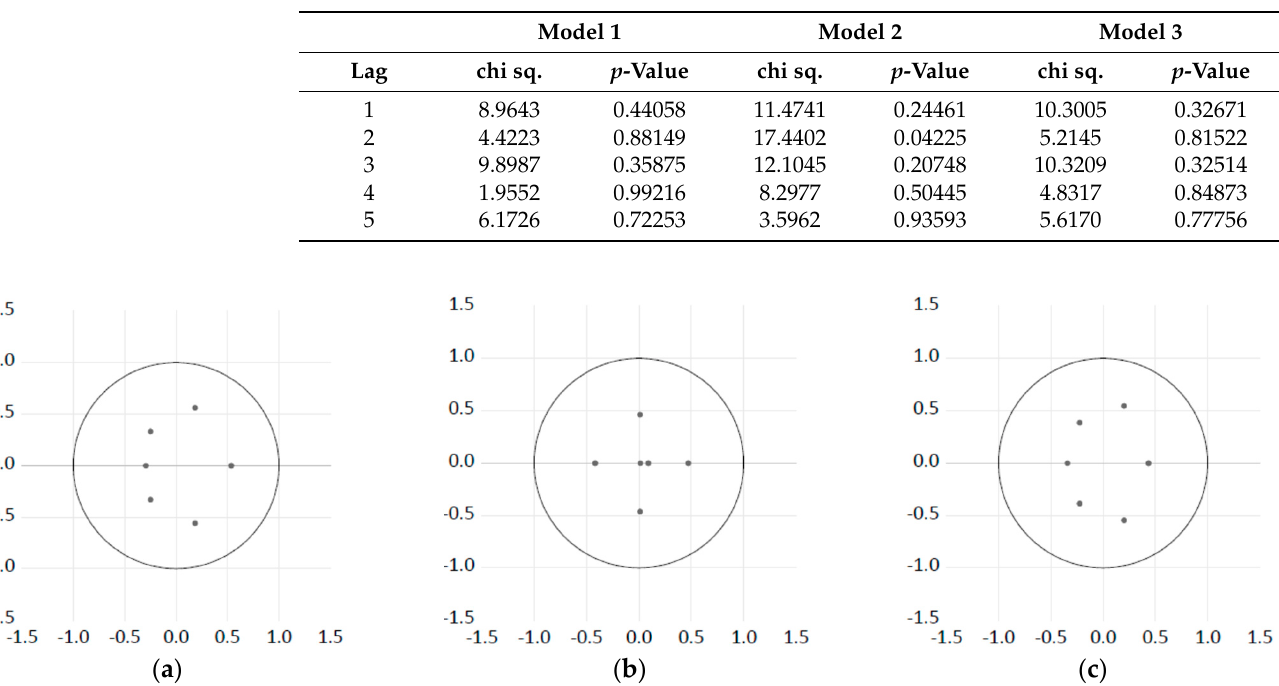
Figure 2. Eigenvalues of the companion matrix for: ( a ) model 1; ( b ) model 2; and ( c ) model 3.